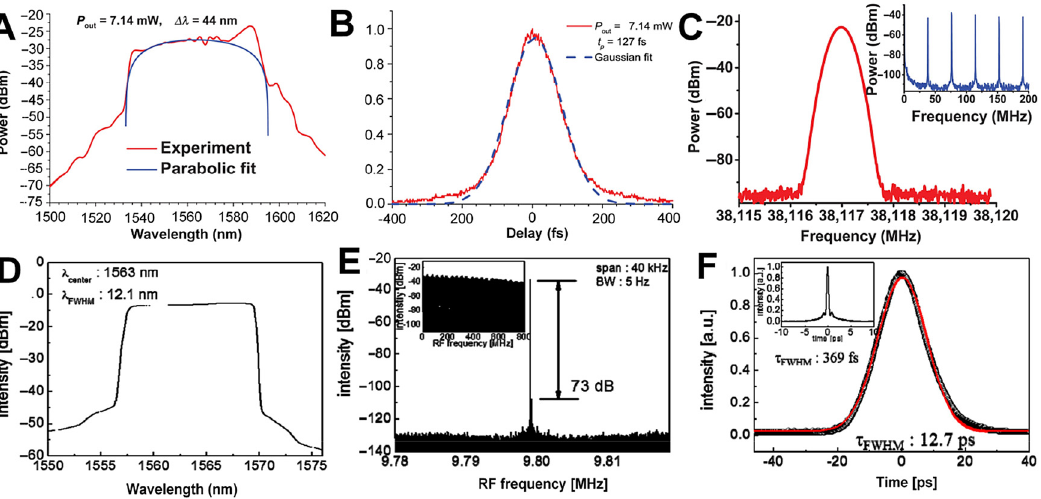
Figure 6: Laser output of the SsPs and DSs at ∼ 1.55 μ m from the CNT-SA based mode-locked fi ber laser. (A) – (C) Optical spectrum, autocor- relation and radio frequency spectrum of SsPs, Lazarev et al. [150]. © IEEE 2016; (D) – (F) Optical spectrum, radio frequency spectrum and autocorrelation of DSs, Jeong et al. [151]. © Optical Society of America